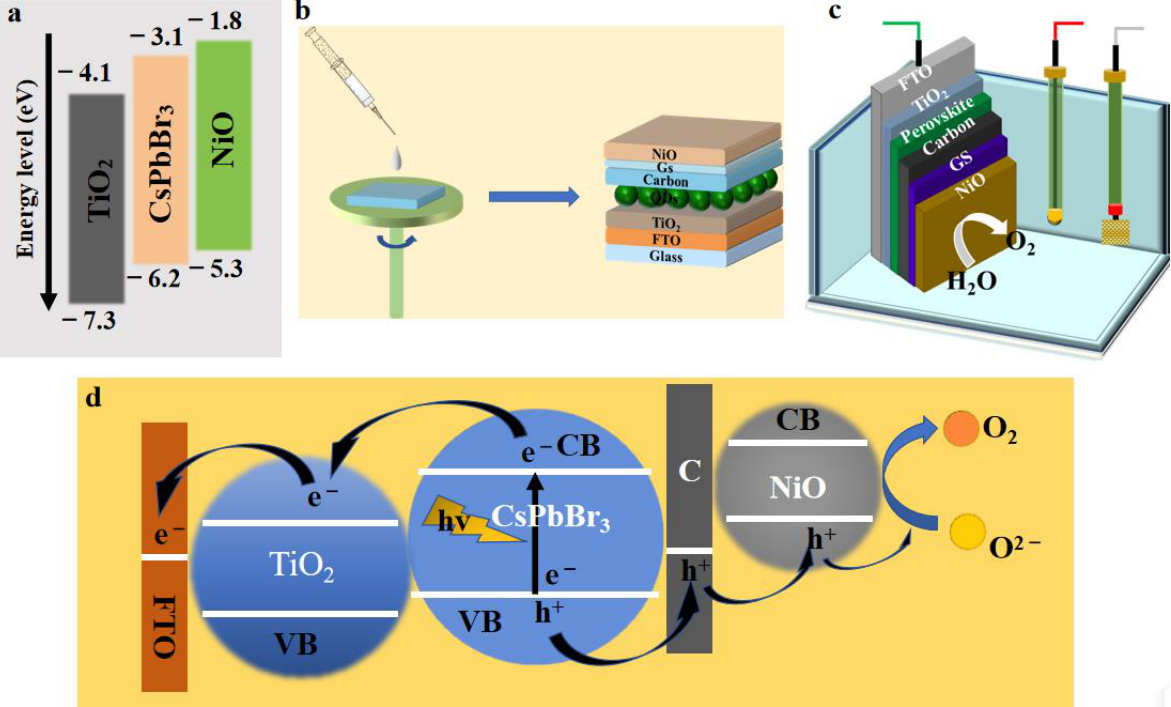
Figure 3. ( a ) Energy level structure diagram of TiO 2 , CsPbBr 3 , and NiO; ( b ) schematic diagram of photocatalytic device constructed by solution method; ( c ) schematic diagram of a photochemical test of a perovskite-type optoelectronic device using a standard three-electrode system with the photocatalytic device backlit from the FTO side; ( d ) diagram of photocatalytic activity mechanism of CsPbBr 3 QDs photoelectric devices.